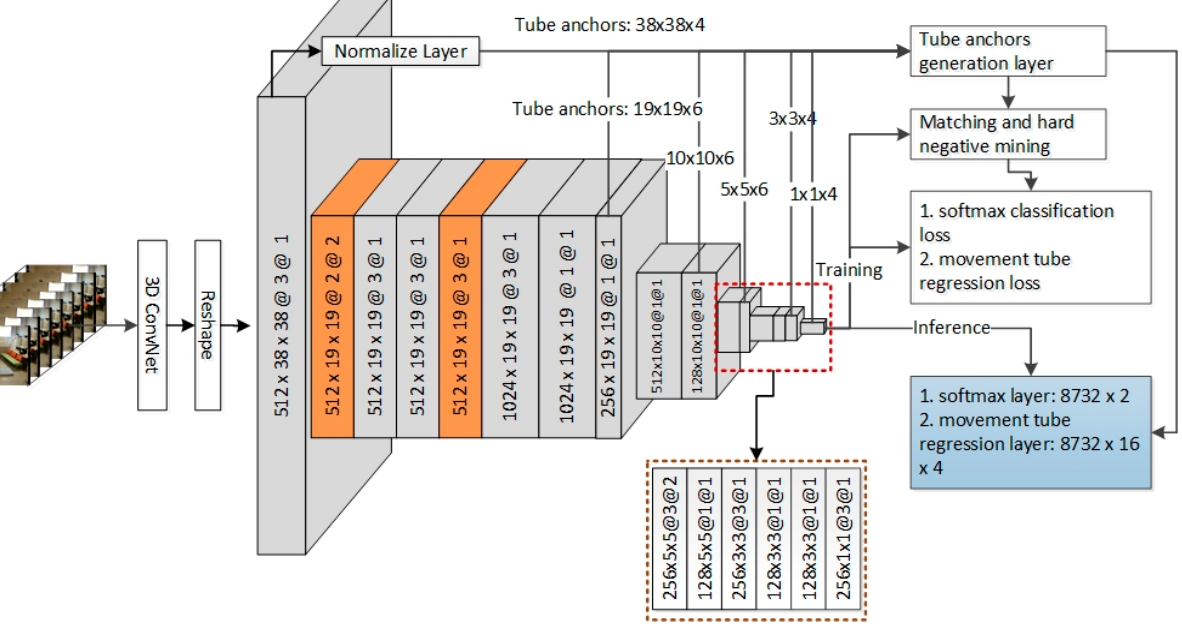
Figure 3. The structure of movement tube detection network. It consists of three components: 3D ConvNet, tube anchors generation layer, and output layer.